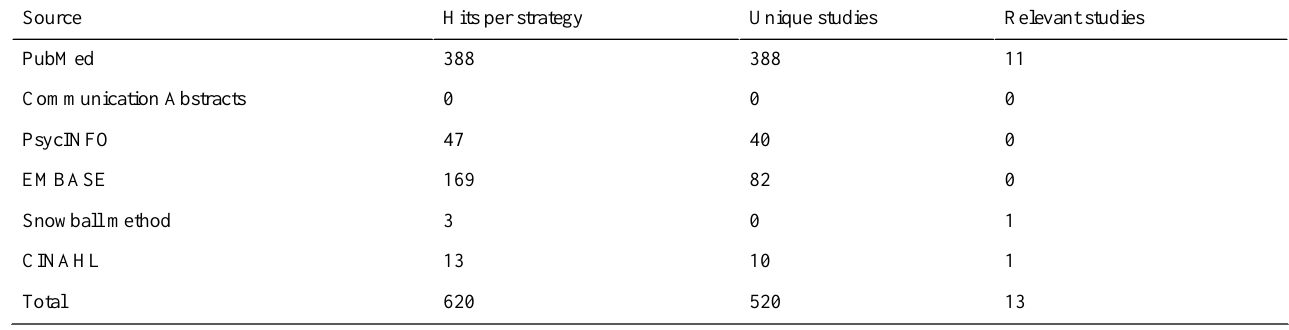
Table 1. Results of database searches.